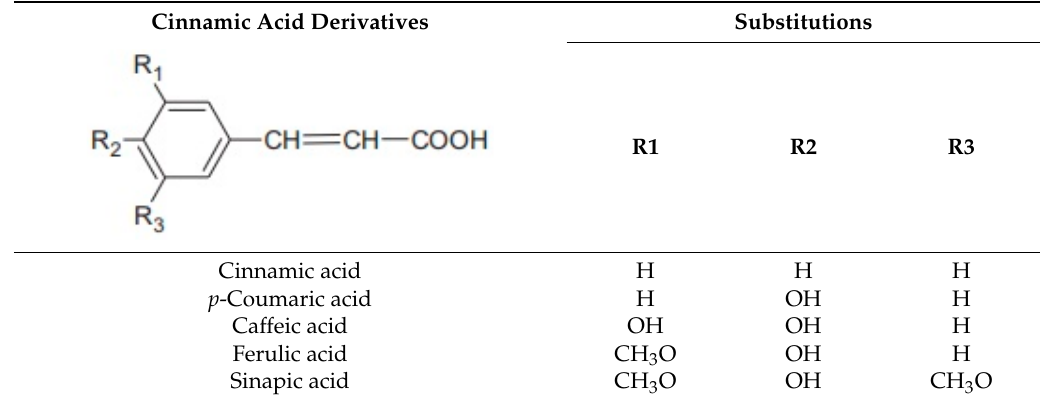
Table 2. Cinnamic acids derivates.